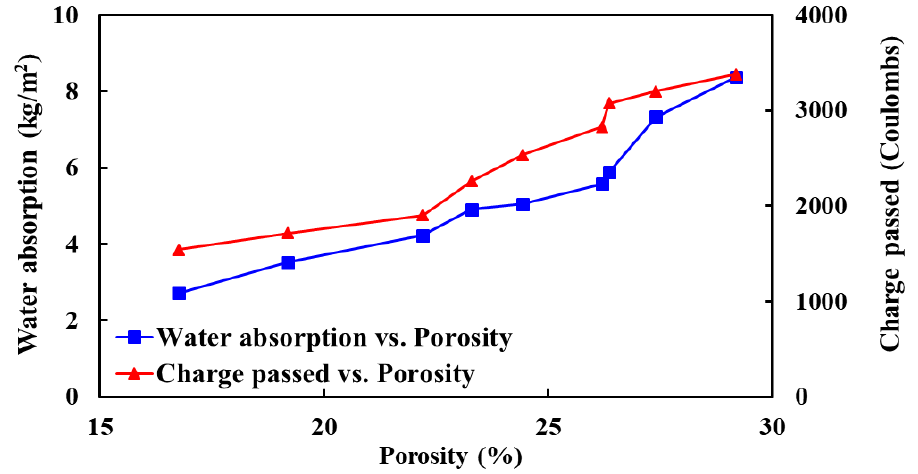
Figure 13. Porosity versus water absorption and charge passed of concrete mixes made with different percentages of IFSSA.